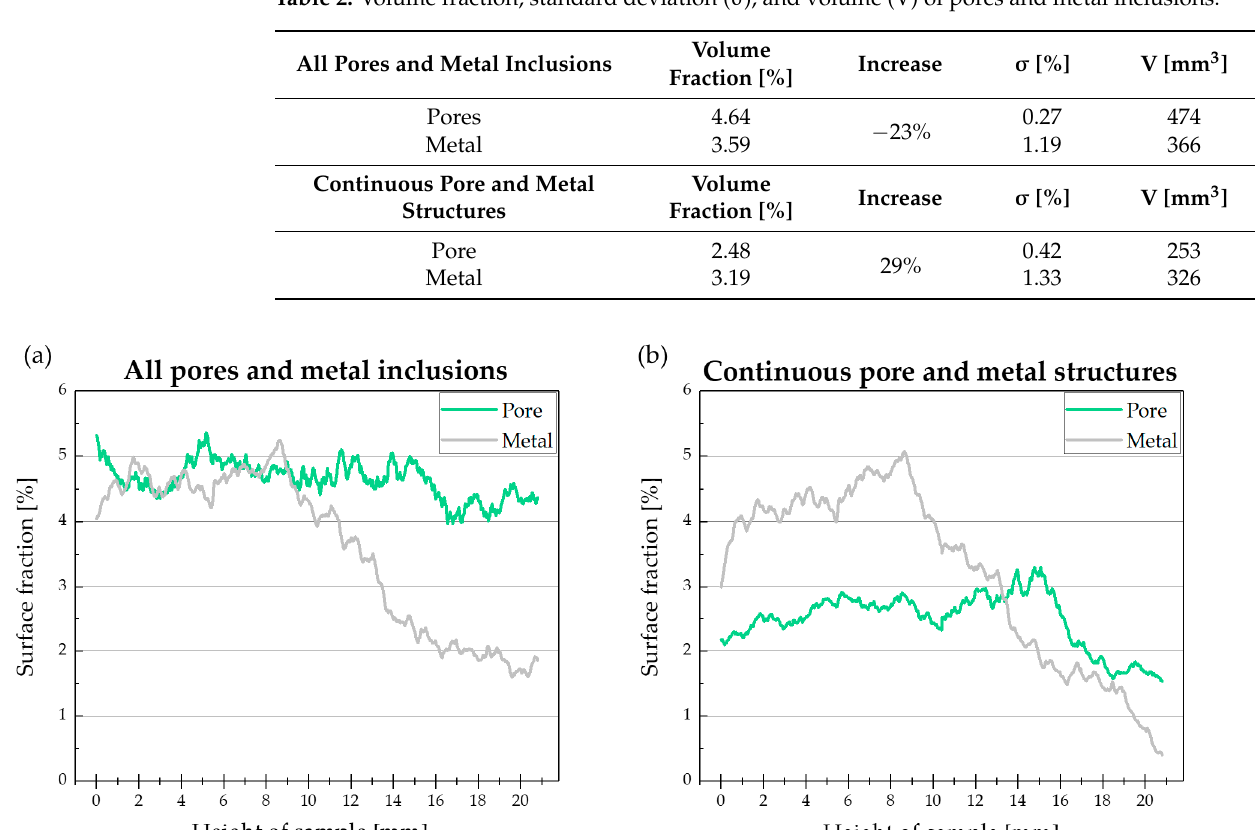
Figure 8. Visualization of ( a ) all pores in the initial sample, ( b ) all metallic inclusions in the sample after the test, ( c ) con- tinuous pore structure, and ( d ) continuous metal structure. Table 2. Volume fraction, standard deviation ( σ ), and volume (V) of pores and metal inclusions.